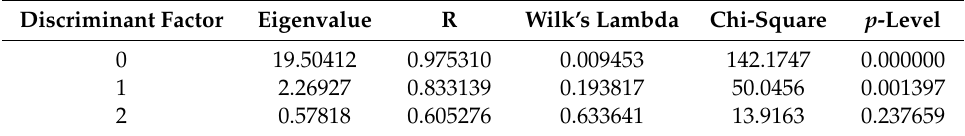
Table 4. Wilk’s lambda and chi-square test for the discriminant analysis of temporal variation.